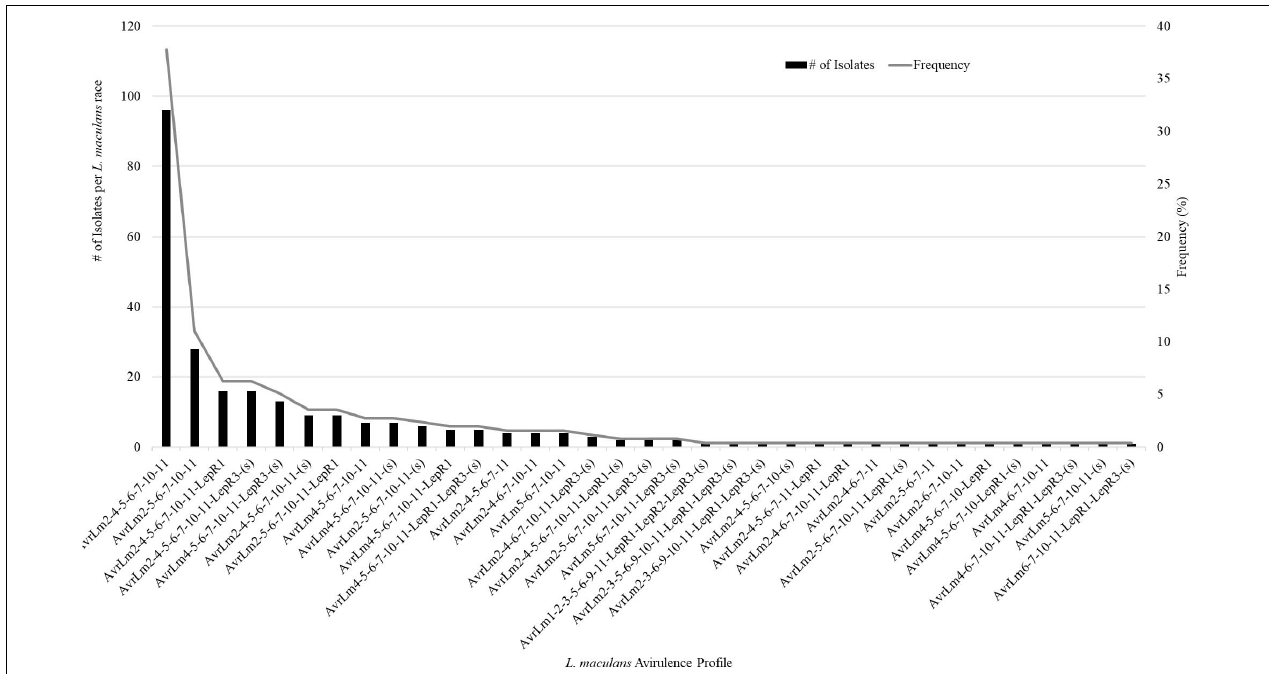
FIGURE 3 | Frequency of 35 Leptosphaeria maculans races characterized on the 14 avirulence alleles included in this study. A total of 359 isolates were examined the avirulence alleles, 105 of the isolates were L. biglobosa.